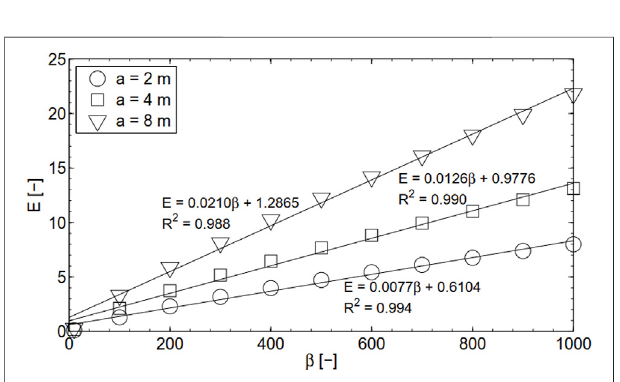
FIGURE 7 | Sensitivity of E to β for a = 2, 4, and 8 m, with b = 50 m and c = 3000